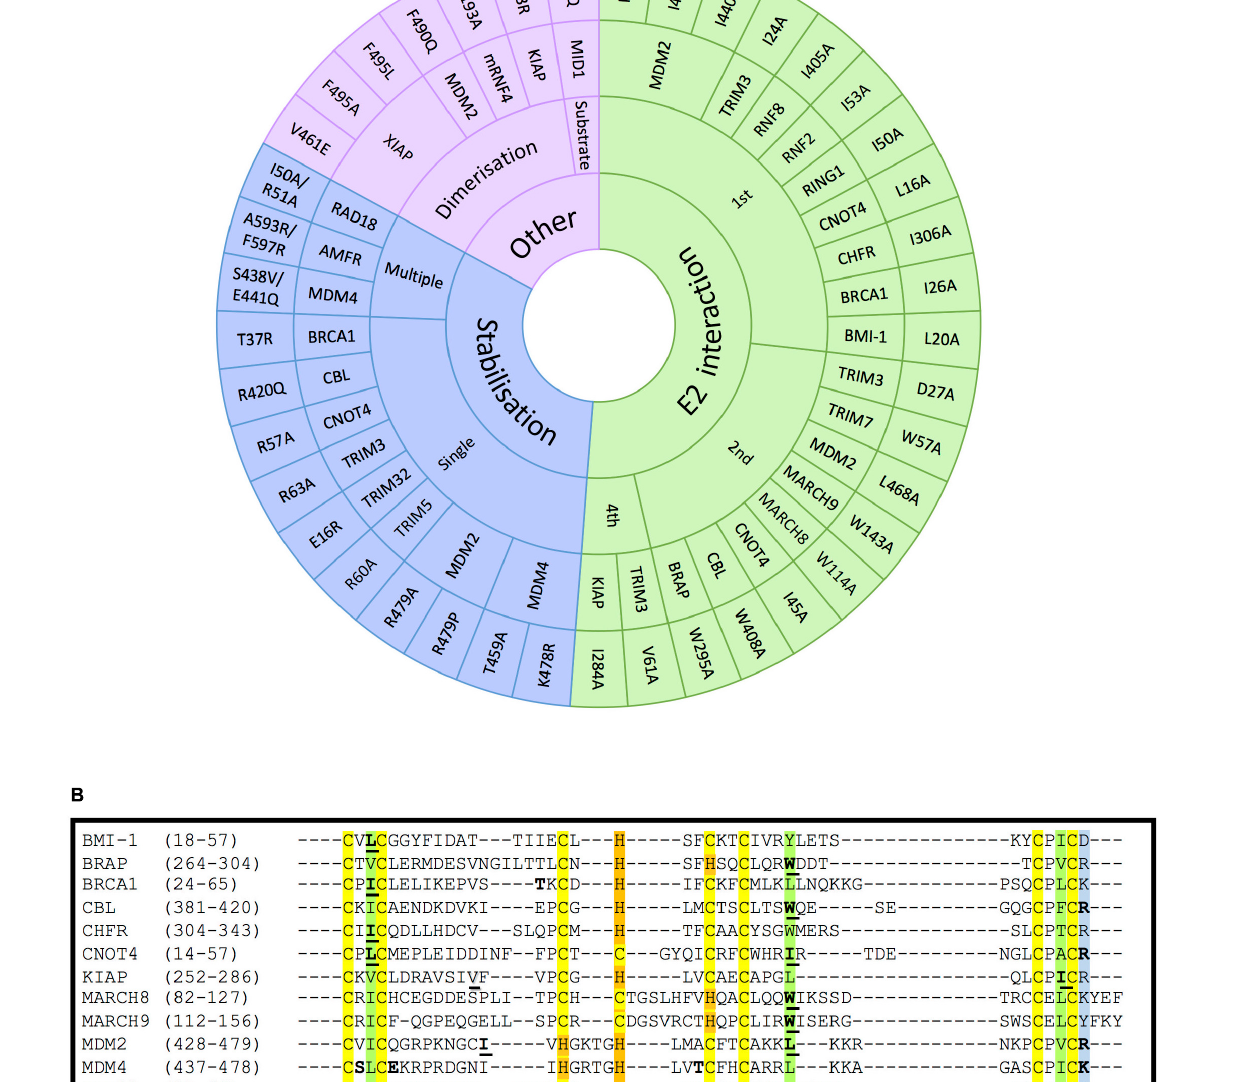
Frontiers in Cell and Developmental Biology |